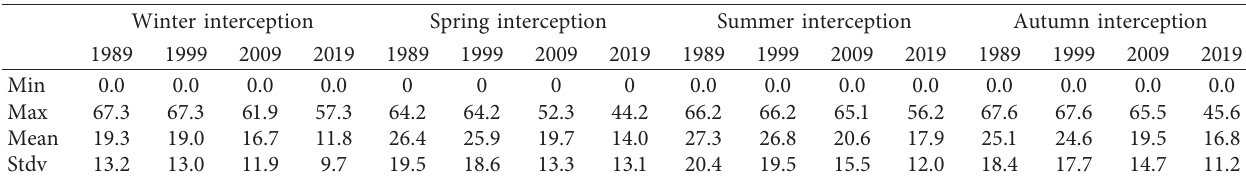
Table 10: Long-term seasonal WetSpass-M simulated interception (mm) of the Bilate basin for a LULC (1989, 1999, 2009, and 2019). Winter interception Spring interception Summer interception Autumn interception